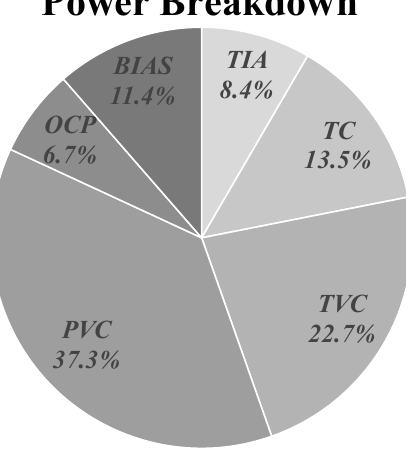
Figure 15. Power breakdown of the prototype LADAR receiver.